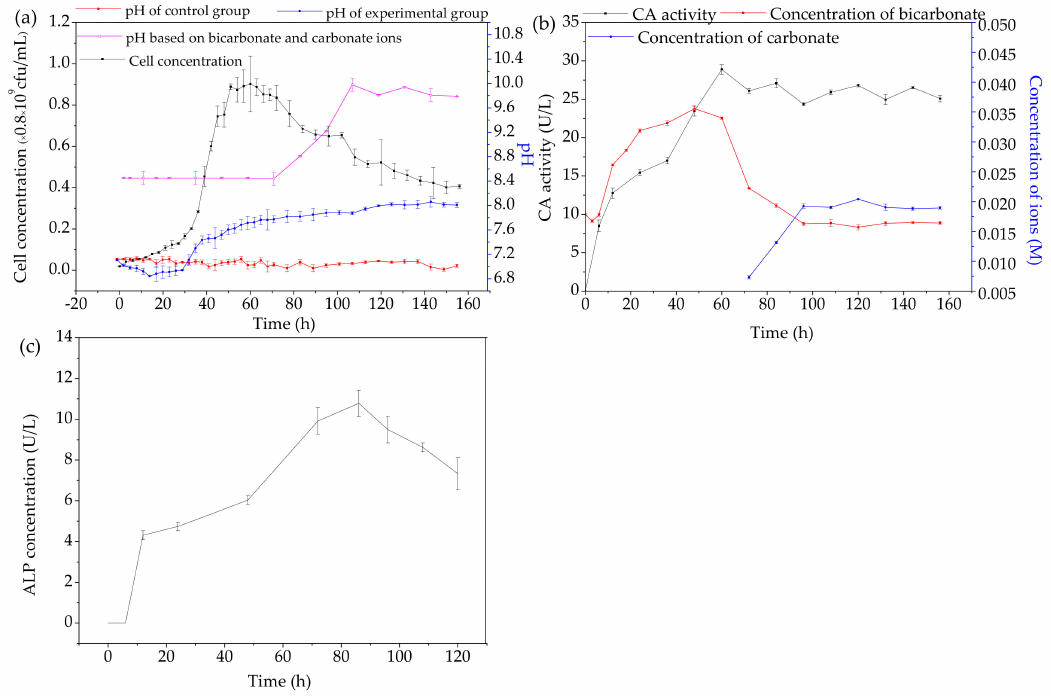
Figure 1. Concentration of C. freundii ZW123 bacteria and di ff erent pH curves ( a ) and CA activity and concentration of carbonate and bicarbonate ions ( b ) and ALP activity of ZW123 bacteria ( c